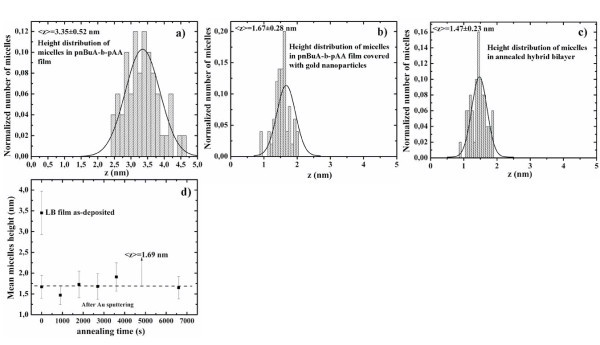
Height distribution of the micelles after each deposition step of as deposited and annealed samples: Micelles height versus annealing time (d) and relative height distribution of micelles size of PnBuA-b-PAA film before sputtering (a), after sputtering (b), after thermal annealing (c).